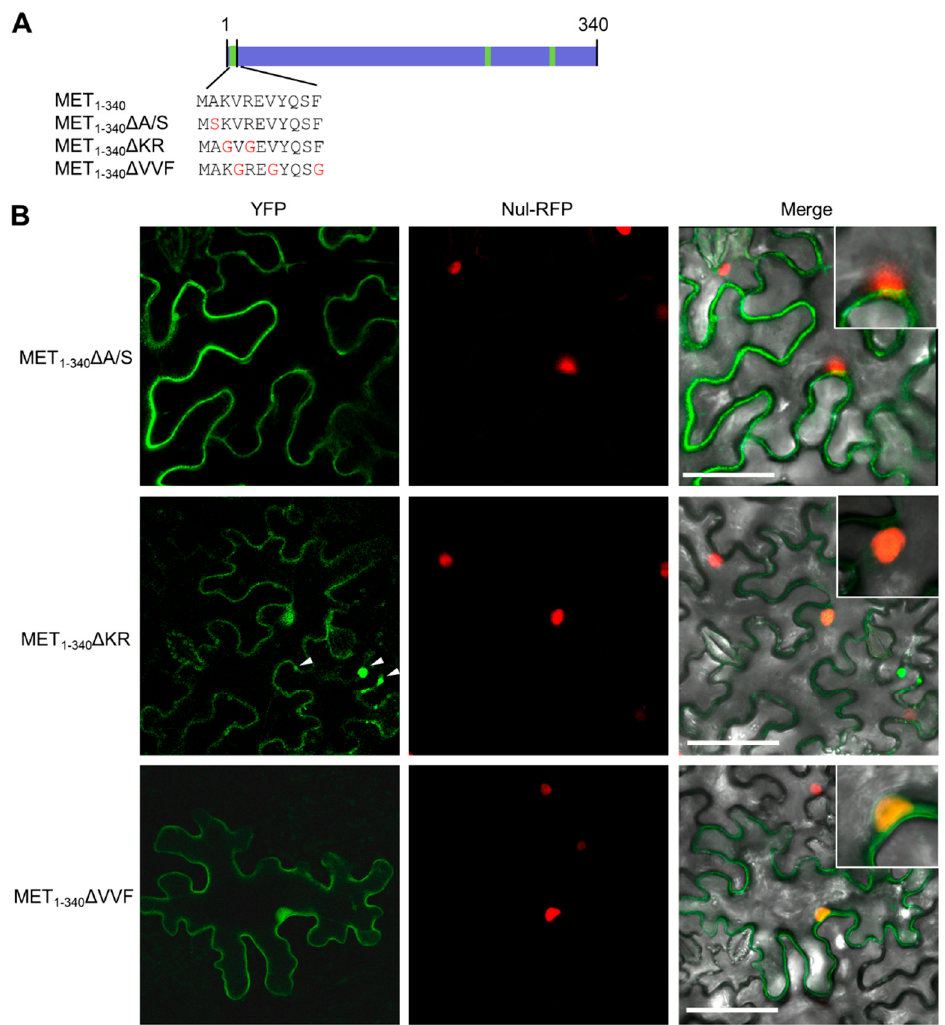
Figure 4. Hydrophobic residues in the first α -helix are required for multimerization . ( A ) Illustration of point mutants of MET 1-340 . The three putative membrane-association motifs in MET 1-340 are highlighted in green. ( B ) Confocal microscopic photos of N. benthamiana epidermal cells expressing MET 1-340 ∆ A/S-YFP, MET 1-340 ∆ KR-YFP, and MET 1-340 ∆ VVF-YFP at 2 dpi. The nucleus was labeled by H2-mRFP. Insets show the typical nuclear signal. Scale bars = 50 µ